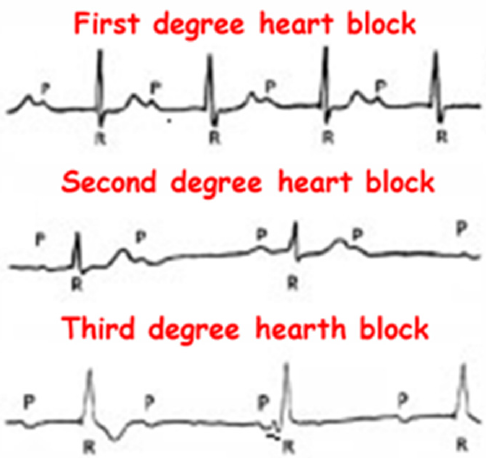
Figure 1. A schematic example of 1st, 2nd and 3rd degree AV block is shown as they appear on a 12-lead ECG.